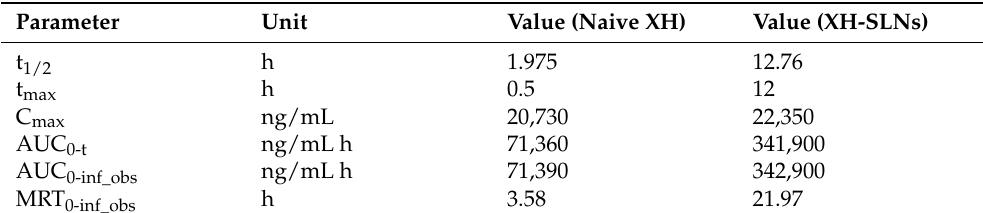
Table 7. Representing the pharmacokinetic data of XH and XH-SLNs.